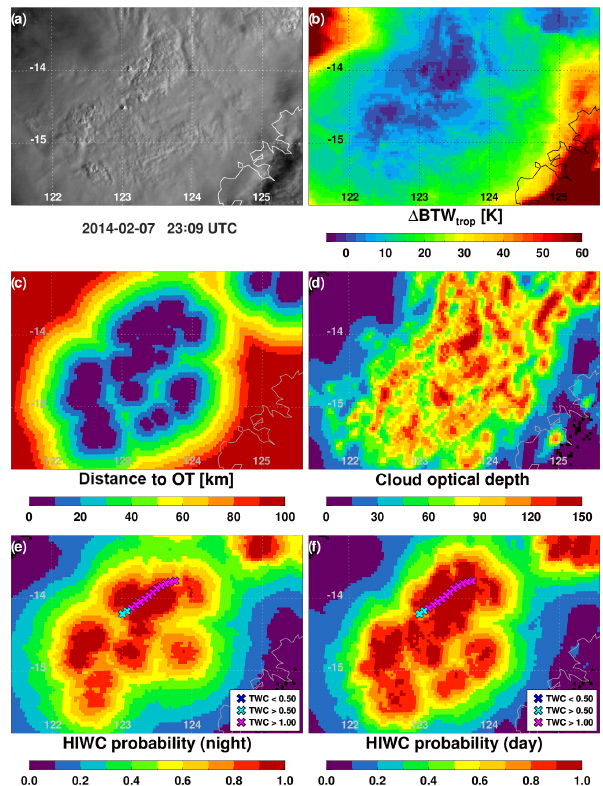
Figure 7. A series of MTSAT-1R JAMI observations and de- rived products for an image during Falcon 20 Flight 16, times- tamped at 23:09UTC but valid over Australia at 23:12UTC on 7 February 2014. (a) 0.73µm VIS reflectance, (b) (cid:49) BTW, (c) dOT, (d) smoothed COD, (e) PHIWC night , and (f) PHIWC day . Panels (e) and (f) are overlaid with 45s mean TWC observations from 23:07 to 23:17UTC.